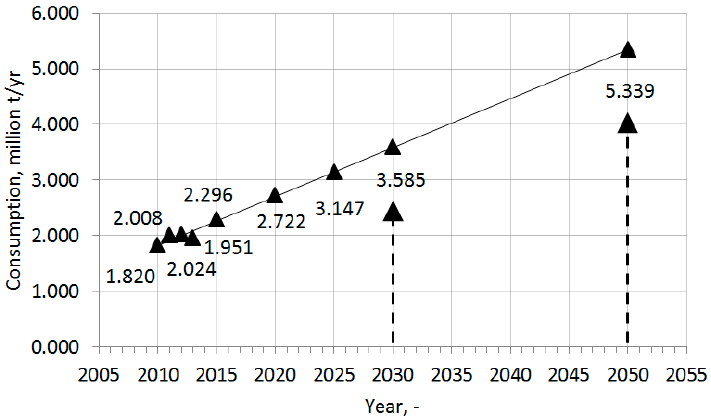
Figure 4. Demand for polymers in the polish economy. Actual data (2010–2015) and projected values